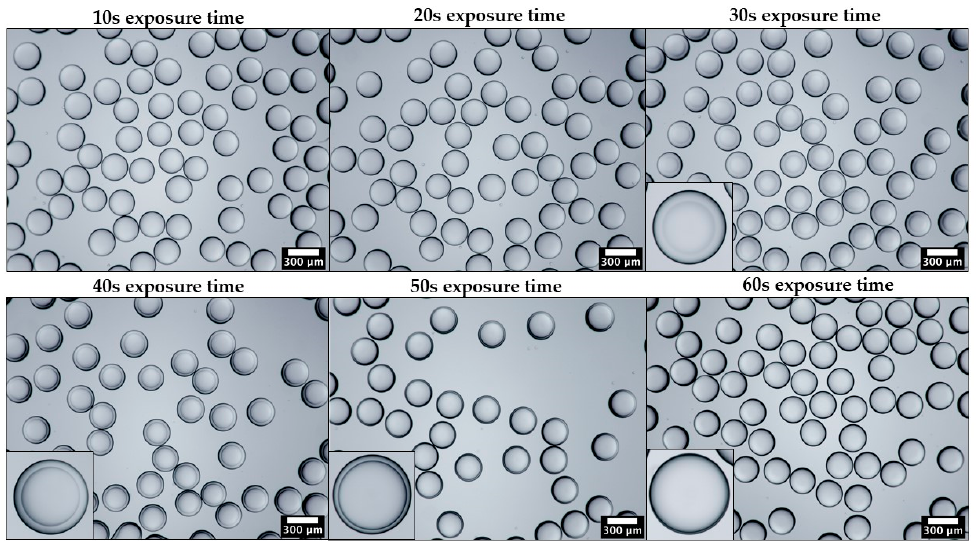
Figure 3. Optical microscopy images of PEGDA particles produced using different UV light exposure times and captured using 4× objective lens. The insets show magnified images of individual particles captured using 10× objective lens. The UV light intensity was 75 mW/cm 2 .